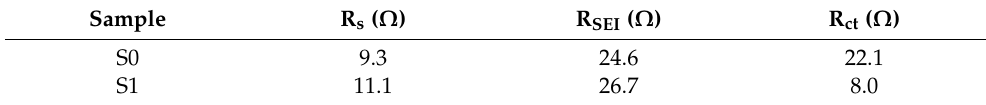
Figure 6. CV curves of the initial three cycles for ( a ) S0 and ( b ) S1. ( c ) Nyquist plots and ( d ) the relationship between Z’ and ω − 1/2 in the low frequency region of S0 and S1. Table 1. The impedance parameters obtained from EIS fitting.